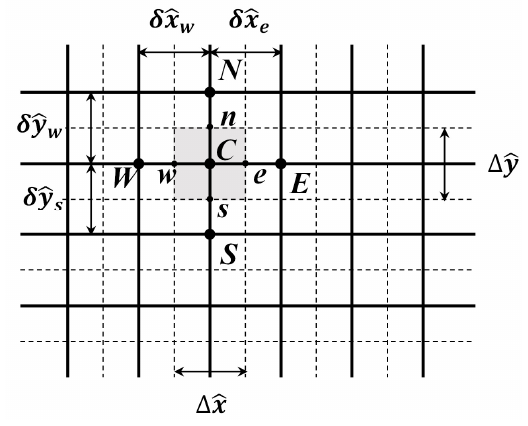
Figure 4. Film grid.